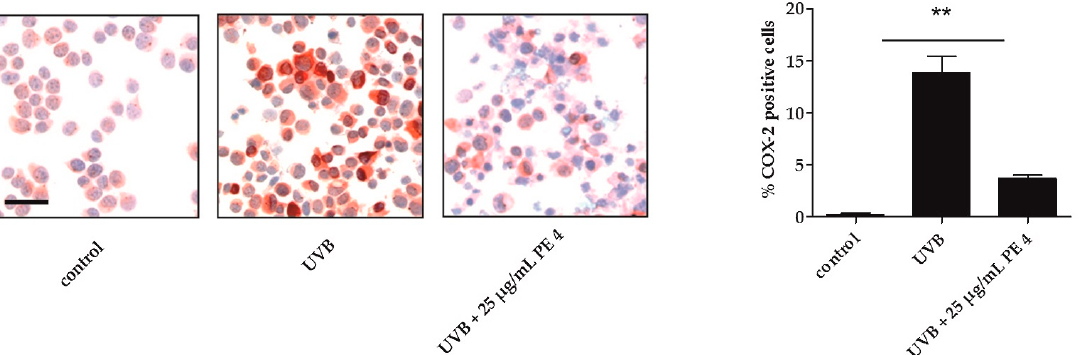
Figure 4. Effect of agrimoniin-enriched fraction PE4 on UVB-induced COX-2 expression. HaCaT cells were irradiated with 30 mJ/cm 2 UVB and treated with 25 µg/mL PE4. Non-irradiated, untreated cells served as control. Subsequently, the cells were centrifuged on slides and COX-2 expression was measured. The graph shows the percentage of COX-2 positive cells per 100 calculated cells in two staining approaches. The bar corresponds to 50 µm. Data are expressed as mean ± SD and the statistical significance was determined compared to the irradiated, untreated control (** p < 0.01).